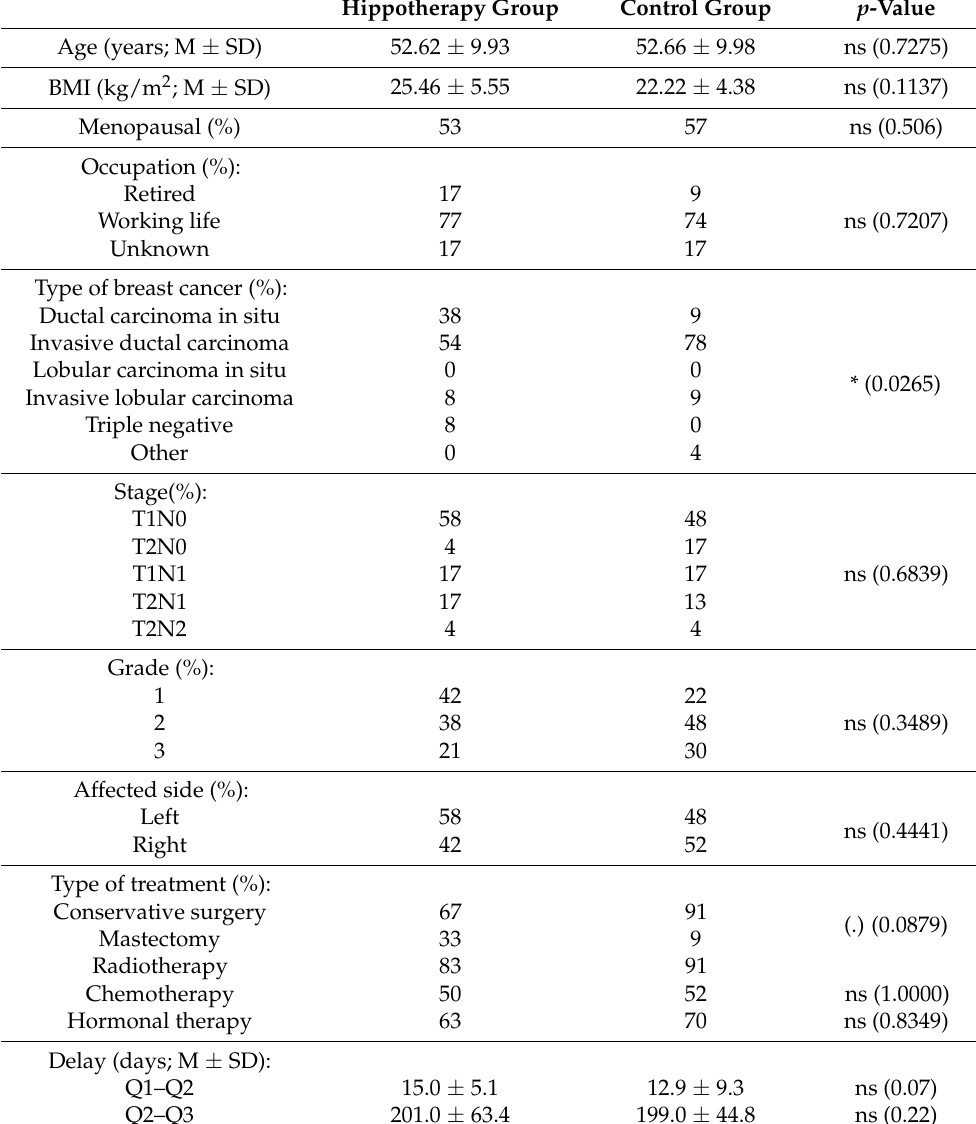
Table 1. Demographic and clinical features of patients in both groups. BMI: Body Mass Index. Q1: questionnaires fulfilled at the inclusion (baseline); Q2: questionnaires fulfilled one week after the first session of hippotherapy; Q3: questionnaires fulfilled after the last hippotherapy session, six months after the beginning of the program. The quantitative data were statistically compared using a two-sided unpaired Wilcoxon test, and the categorical data using a Chi-squared test; (*) p < 0.05; (.) close to significance (between 0.08 and 0.05); (ns)